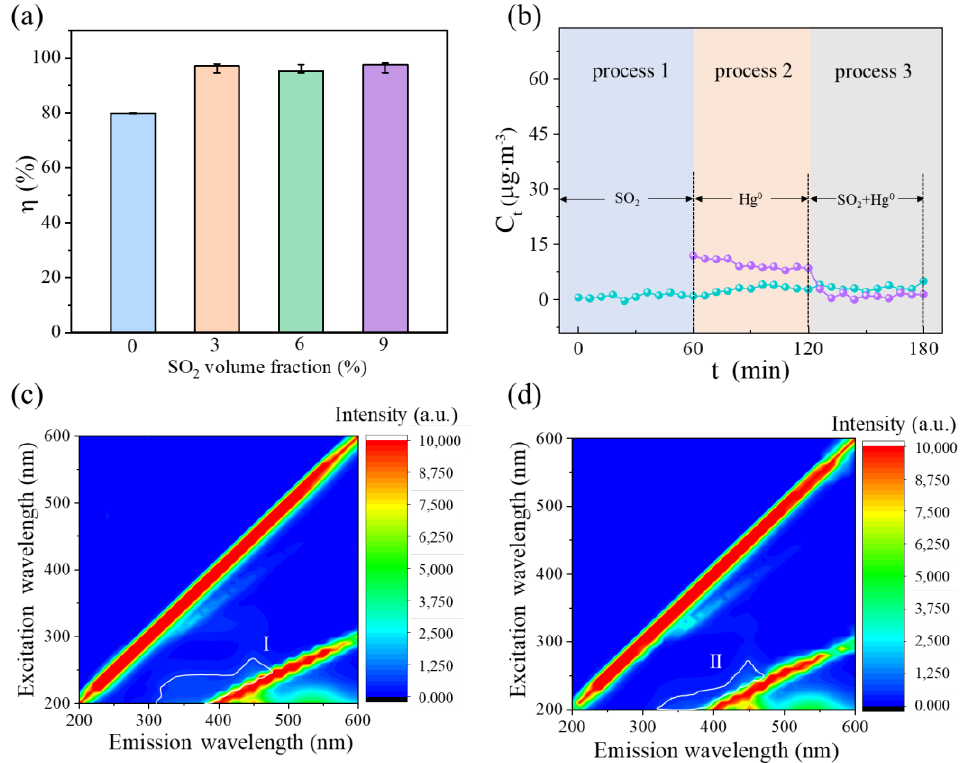
Figure 5. ( a ) The effect of SO 2 on Hg 0 removal efficiency. ( b ) Hg 0 removal performances under SO 2 on – off experiment. ( c ) The 3D-EEM fluorescence spectrum of c-CuS under pure N 2 . ( d ) The 3D-EEM fluorescence spectrum of c-CuS under SO 2 (Experimental condition: solution volume = 10 mL, solution pH = 3.0, solution temperature = 20 °C, flue gas was 0~9% vol SO 2 + N 2 , the inlet concentration of Hg 0 was 200 µg·m −3 ).